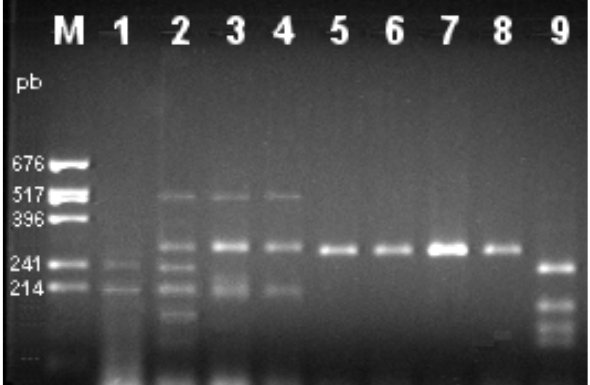
Figura 3. Eletroforese em gel de agarose 2 % da região ITS do rDNA obtido a partir de esporos de populações de FMA nos três estádios de estabilização de